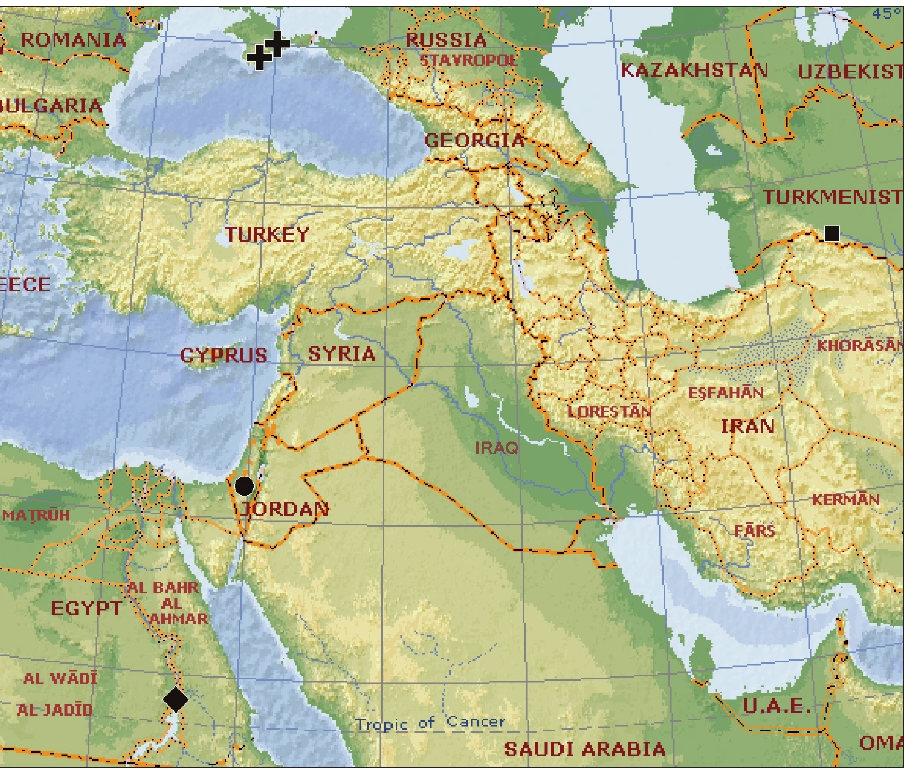
Map 1. A map showing type localities and distribution of Synaphris letourneuxi (  ), S. lehtineni (  ), S. wunderlichi sp. n. (  ) and S . orientalis ( 